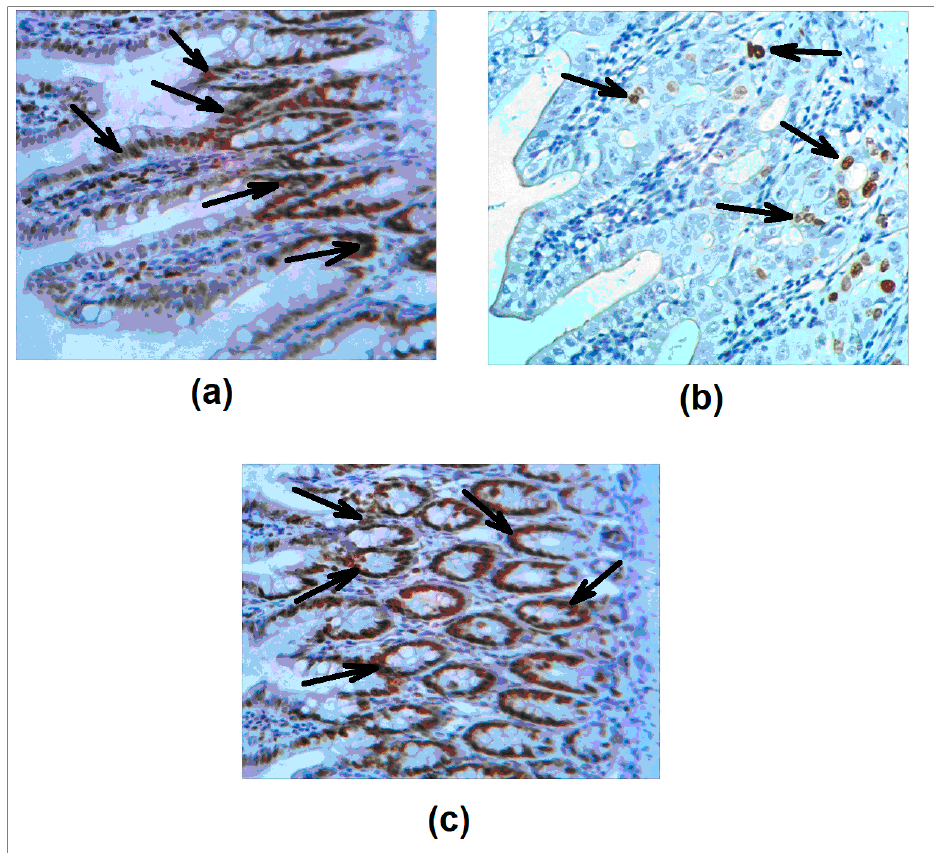
Figure 3. L. brevis 47 f restores 5 FU induced decrease of Ki-67 expression in the gut. ( a ), saline; ( b ), 5 FU; ( c ), L. brevis 47 f + 5 FU. Ki-67 antigen ( arrows ) was detected immunohistochemically (see Materials and Methods ). H&E staining. Initial magnification × 400.